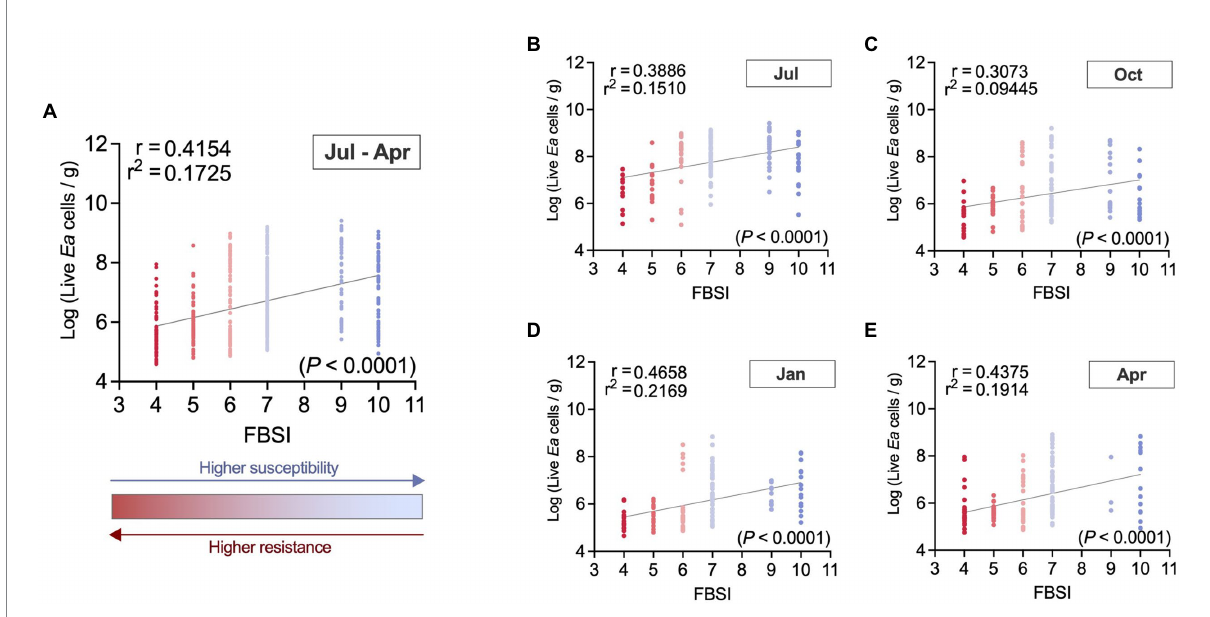
FIGURE 8 Correlation between the fire blight susceptibility index (FBSI) used in this study and E. amylovora population sizes in cankers collected in two independent experiments. Chart (A) describes the overall correlation using all samples collected in two independent experiments and all sampling season time points from July through April of the next year ( N = 604). Charts (B–E) also contain pooled data from the two experiments but show the results from cankers collected in July ( N = 153) (B) , October ( N = 157) (C) , January ( N = 129) (D) and April ( N = 165) (E) . Dots correspond to live E. amylovora population data from individual cankers, colored to depict the host’s resistance/susceptibility to fire blight estimated with the fire blight susceptibility index (FBSI). Each chart shows Pearson’s coefficient of correlation ( r ), coefficient of determination ( r 2 ), regression line and p